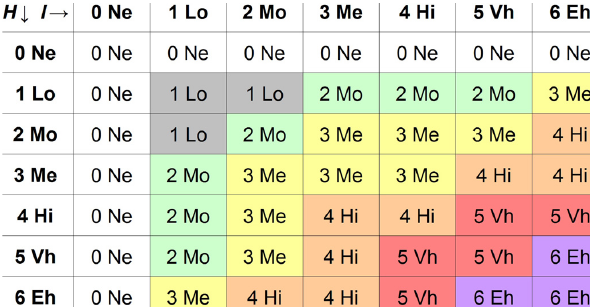
Fig. 4. Matrix for the impact hazard HI rating based on the ratings for lake outburst hazard rating H and impact susceptibility I . The abbreviations are explained in the legend of Fig.